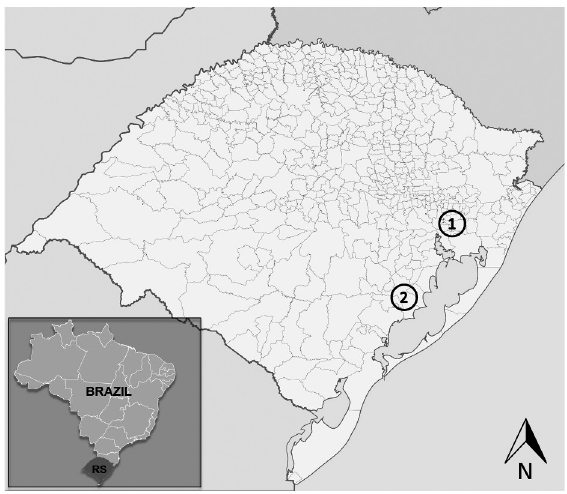
Figure 1 - Map of the water quality in the monitoring rice culture areas in South Brazil. (1) Cachoeirinha and (2)